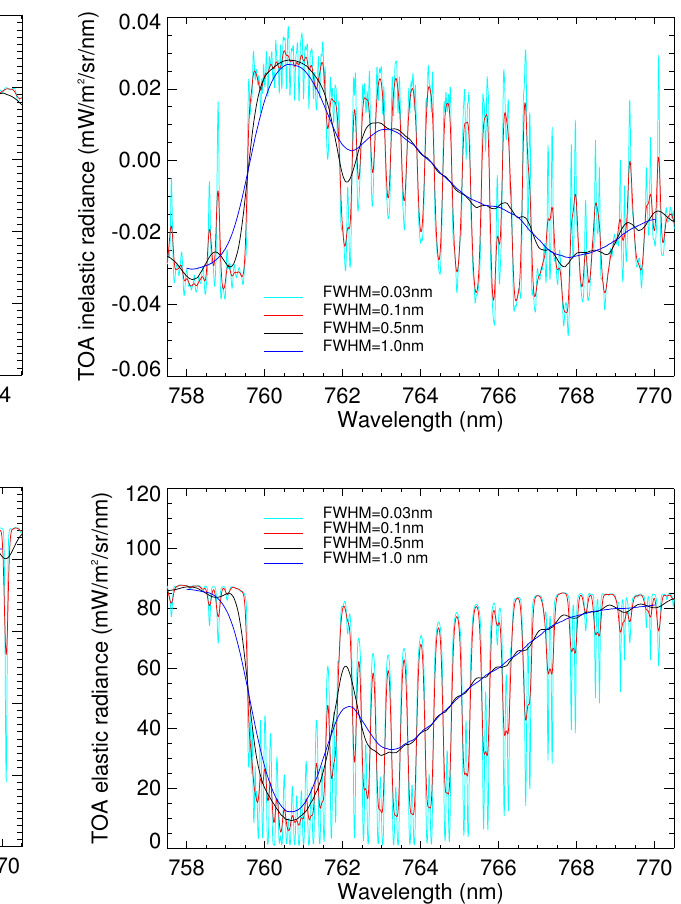
Fig. 1. Rotational-Raman spectra of (a) N 2 and (b) O 2 for excitation wavelength 760 nm. Line strengths are normalized such that the sum over all lines is equal to unity.